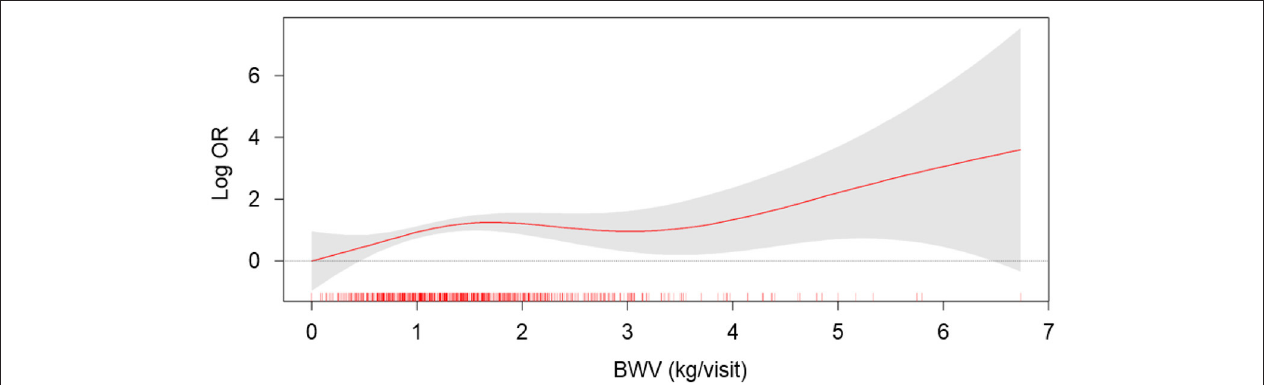
FIGURE 3 | The restricted cubic spline of BWV on the risk of rapid progression of CAC. Adjusted OR of BWV as a continuous variable for the risk of rapid progression of CAC is depicted. The model was adjusted for age, gender, Charlson comorbidity index, smoking history, BMI, SBP, DBP, medication (ACEi/ARBs, diuretics, number of antihypertensive drugs, statins), hemoglobin, albumin, HDL-C, fasting serum glucose, 25(OH) vitamin D, hs-CRP, eGFR, spot urine ACR, and baseline CACS. BWV, body weight variability; OR, odds ratio.